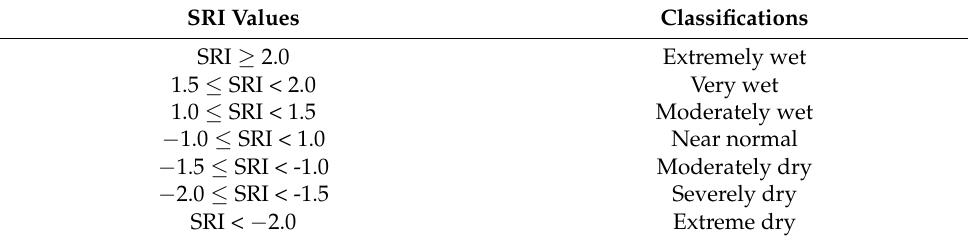
Table 2. Classification of drought conditions according to the SRI. SRI Values Classifications SRI ≥ 2.0